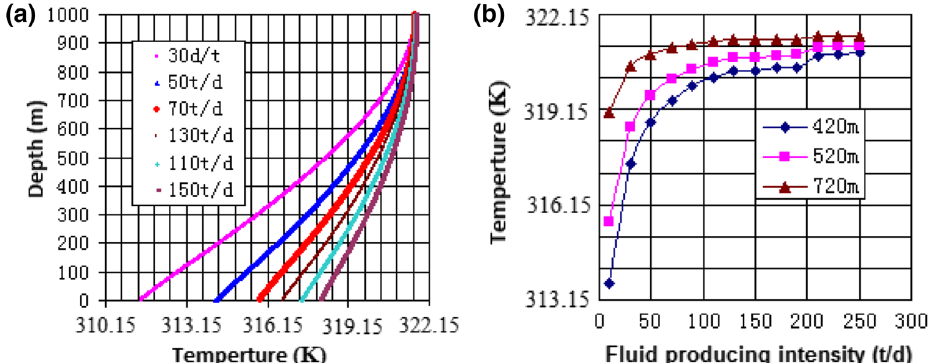
Fig. 5 Temperature of tubing for different fluid producing intensities Fig. 6 Temperature of tubing for different moisture contents